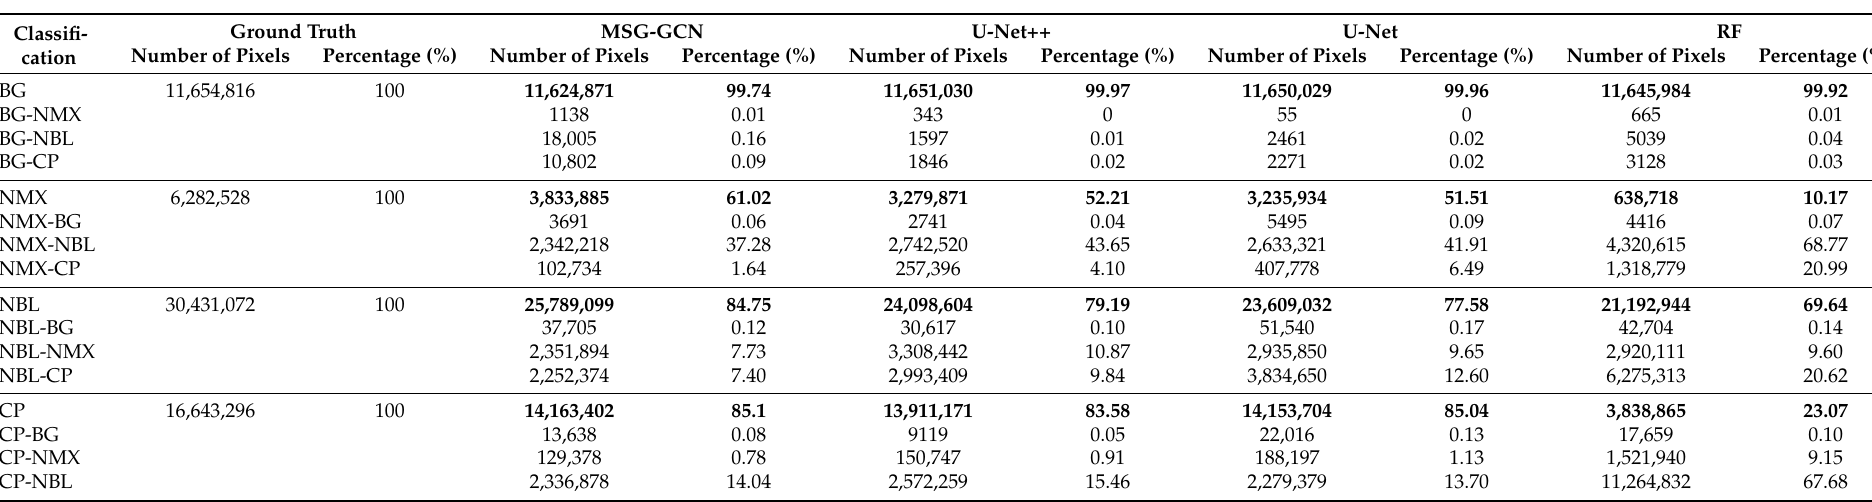
Table 2. Areas and percentages of forest types correctly classified and misclassified by the RF, U-Net, U-Net++, and MSG-GCN